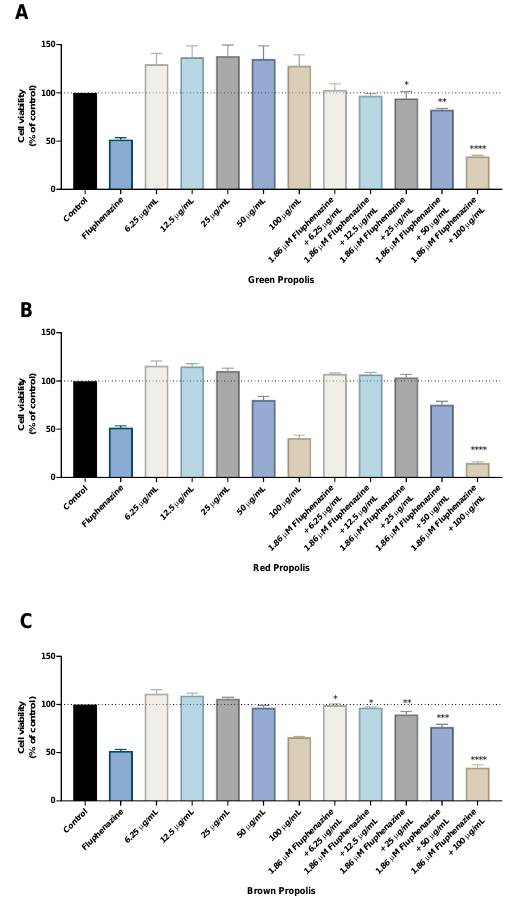
Figure 5. Cell viability of HT-29 colon cancer cells treated with the combination of different propolis extracts and fluphenazine. Cultured cells were seeded in 96-well plates and exposed to increasing concentrations of each propolis extract combined with the IC 50 value of fluphenazine (1.86 μM) for 48 h. Cell viabilities were determined after the final treatment by MTT. The drugs in combination were co-administered at the same time. ( A ) The effect of fluphenazine plus green propolis on cell viability. ( B ) The effect of fluphenazine plus red propolis on cell viability. ( C ) The effect of fluphenazine plus brown propolis on cell viability. Each point represents the mean ± SEM relative to the control untreated cells. * statistically significant vs. control at p < 0.05. ** statistically significant vs. control at p < 0.01. *** statistically significant vs. control at p < 0.001. **** statistically significant vs. control at p < 0.0001.